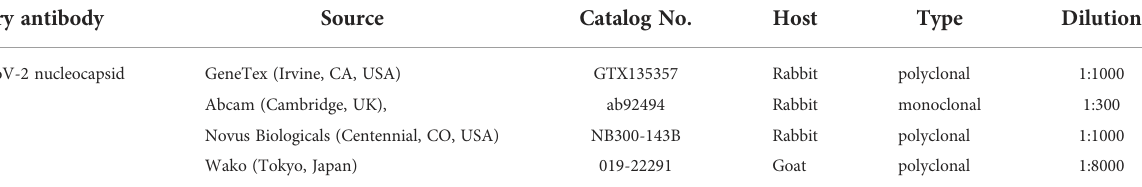
Table 1. Anti-SARS-CoV-2 nucleocapsid antibody was used to identify SARS-CoV-2. The following antibodies were used to evaluate ORN neurogenesis: sex-determining region Y-box 2 (SOX2), expressed by proliferating stem cells or progenitor cells